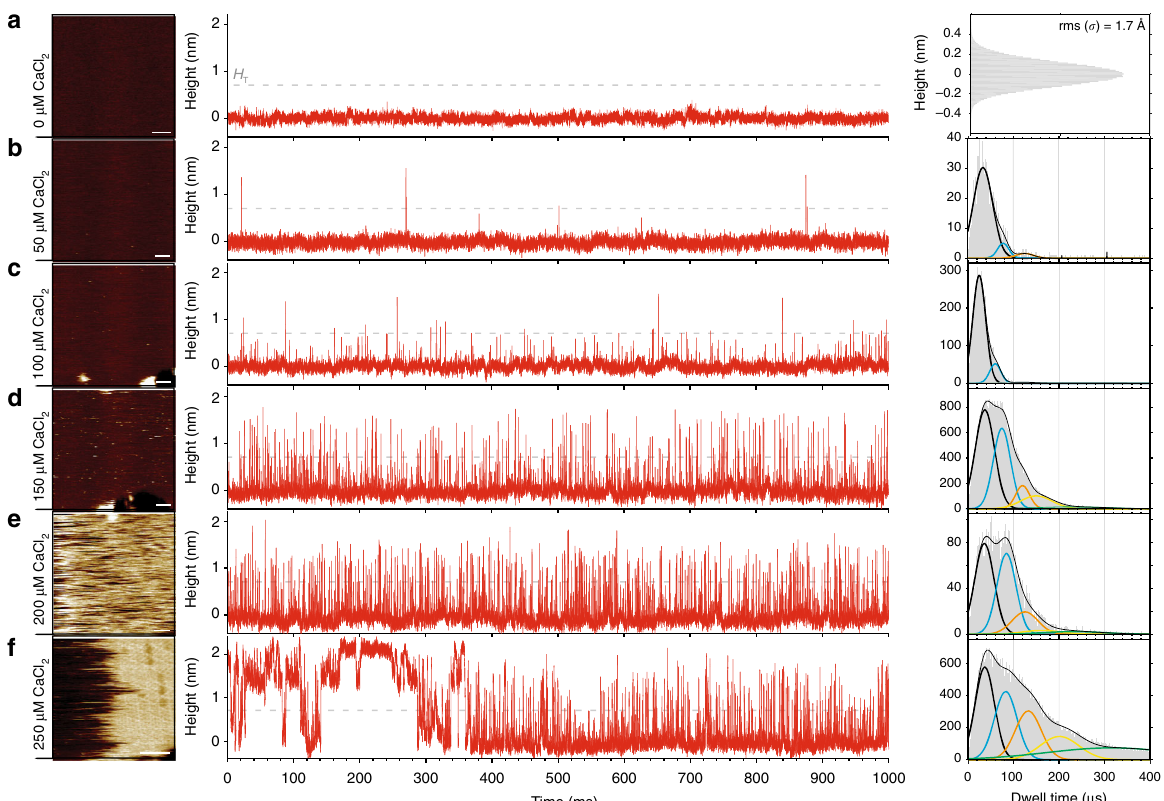
Fig. 2 HS-AFM-HS of diffusion and self-assembly at model membranes. a HS-AFM image frame (left) and height spectroscopy height/time trace (middle) of the membrane (8:2 DOPC/DOPS) surface without Ca 2 + in solution. The histogram (right) shows the full distribution of height values detected indicating a noise level of 0.17 nm at 625 kHz sampling rate. b – f HS-AFM image frames (left) and subsequent height spectroscopy height/time traces (middle) at the membrane surface with 50 µ M ( b ), 100 µ M ( c ), 150 µ M ( d ), 200 µ M ( e ) and 250 µ M ( f ) Ca 2 + in solution. Right: corresponding dwell time ( τ D ) distributions with multi-component Gaussian fi ts. All measurements were performed in the presence of 127 nM annexin-V in solution. Images: Full color scale: 4 nm, scale bars: 50 nm. 1000 ms height/time traces are example sections from longer, typically 60 s,